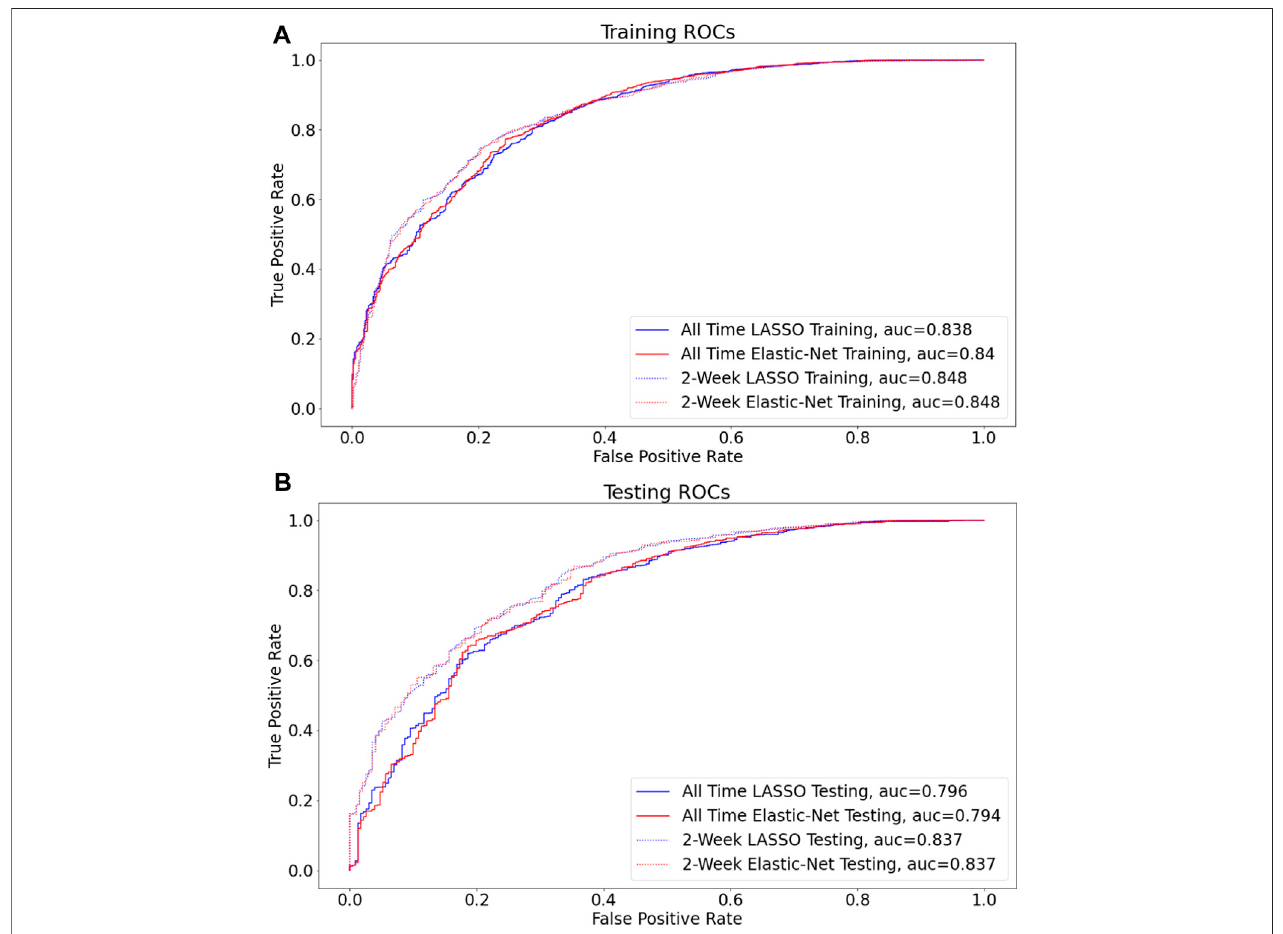
FIGURE2| LASSO vsElastic-Net model performanceontwosets ofdataReceiver operating characteristic(ROC) curves areshown for the fi nalmodel foreach of the four assessed techniques (A,B) , and the corresponding areas under curves (AUC) are presented in the fi gure legend. By AUC on hold out data (0.815), the models built on data fi ltered by two-week before COVID (non)diagnosis perform the best (B).